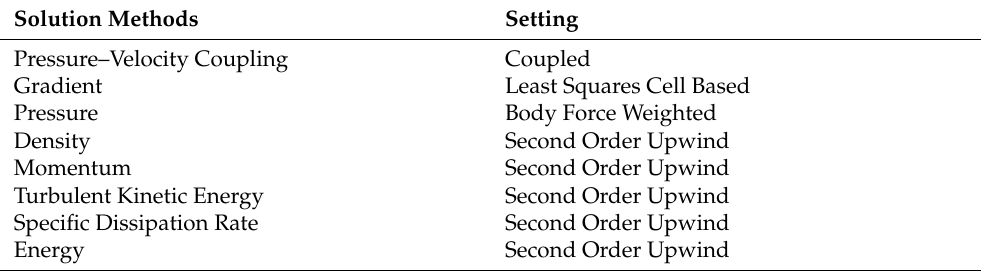
Table 1. Numerical settings.